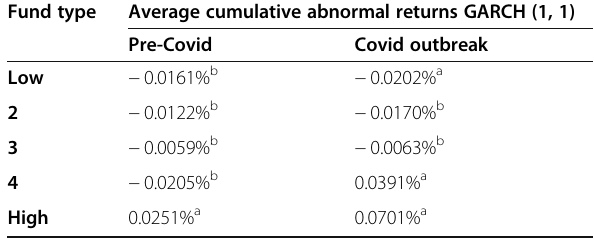
Table 5 Abnormal returns of HCE sorted funds prior to Covid- 19 and during outbreak Fund